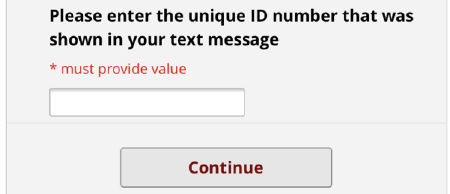
Figure 8. Pre-consultation form: Opening